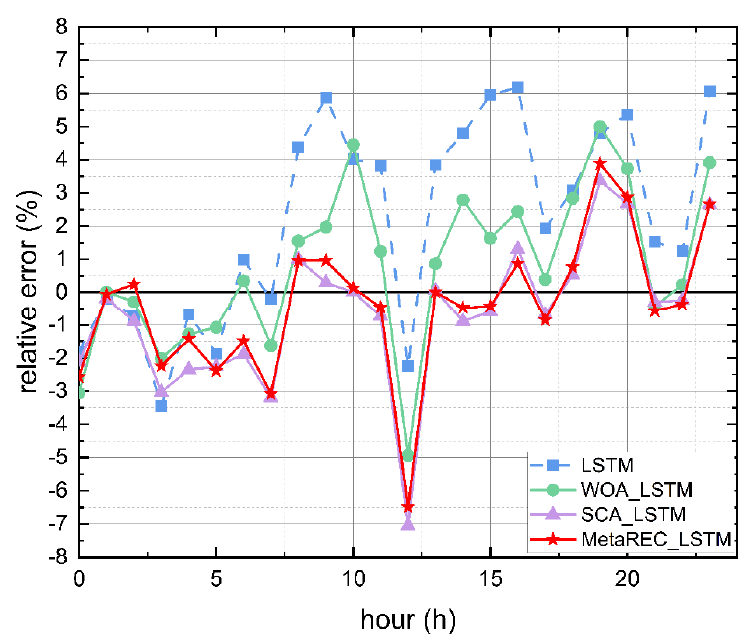
Figure 13. Error rate curves.